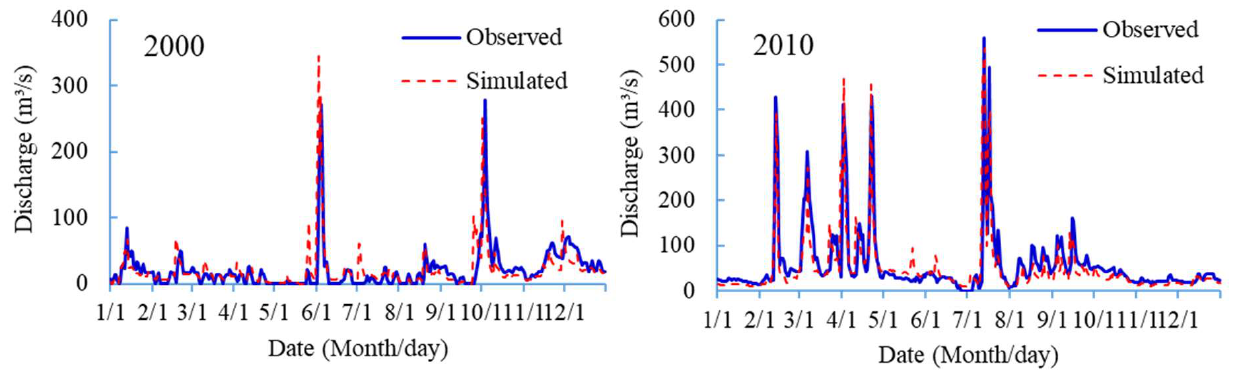
Figure 4. The daily simulated and observed discharges for the typical years (a and b indicate 2000 and 2010).